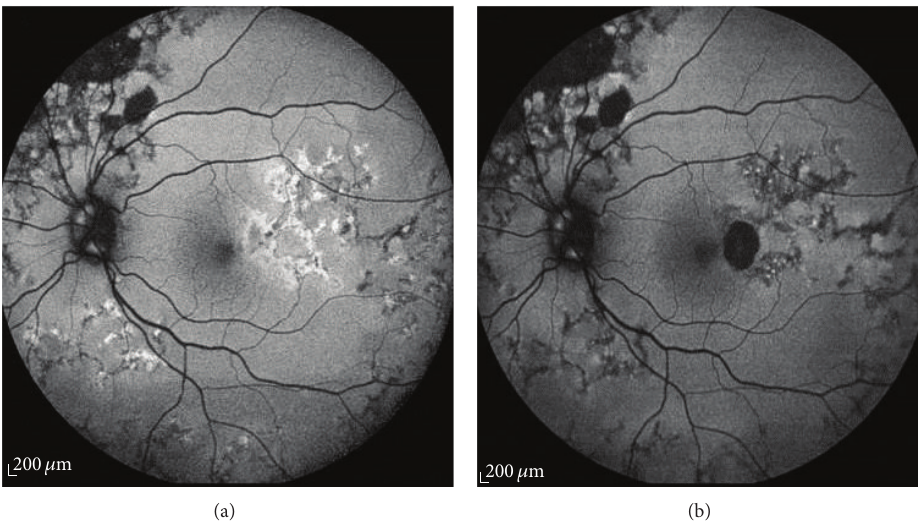
Figure6:Fundusautofluorescenceimageoflefteyeofamalepatientwithtuberculouschoroiditis.(a)Anill-definedhaloofhyperautofluores- cence corresponding to the active lesion, giving it a diffuse, amorphous appearance. (b) Two months later, a thin rim of hypoautofluorescence appears surrounding the predominantly hyperautofluorescent